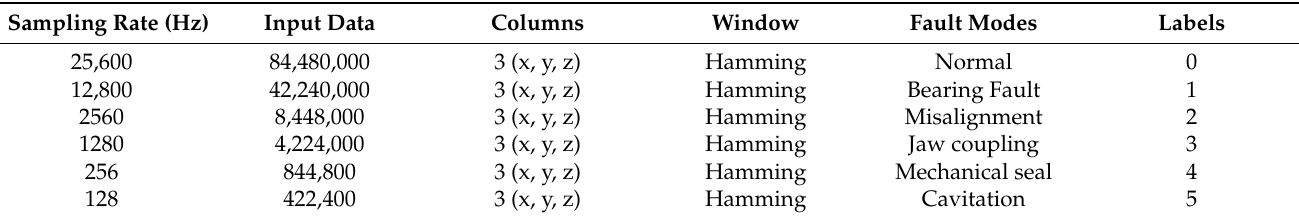
Table 4. Resampling of pump vibration